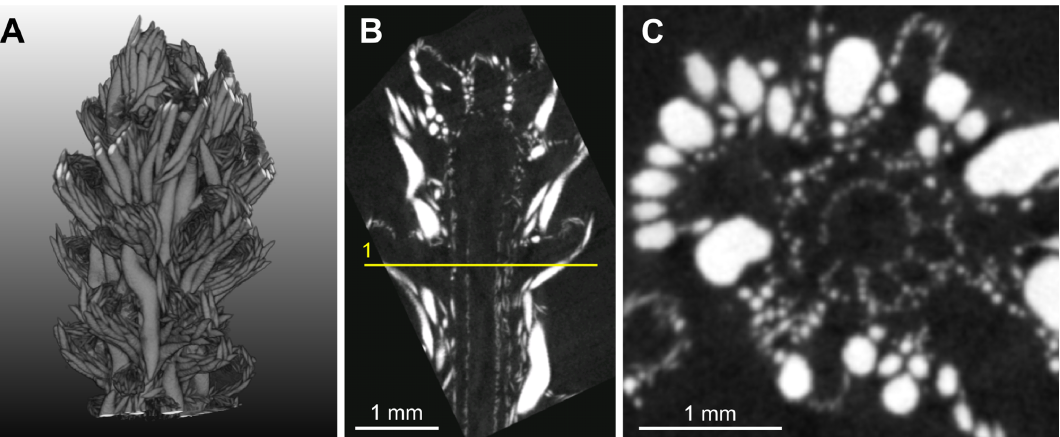
Figure 4. M1 dataset. (A) volume rendering, (B) example of longitudinal slice, (C) axial slice corresponding to the initialization plane. The line superimposed onto the image represents the location of the initialization plane.